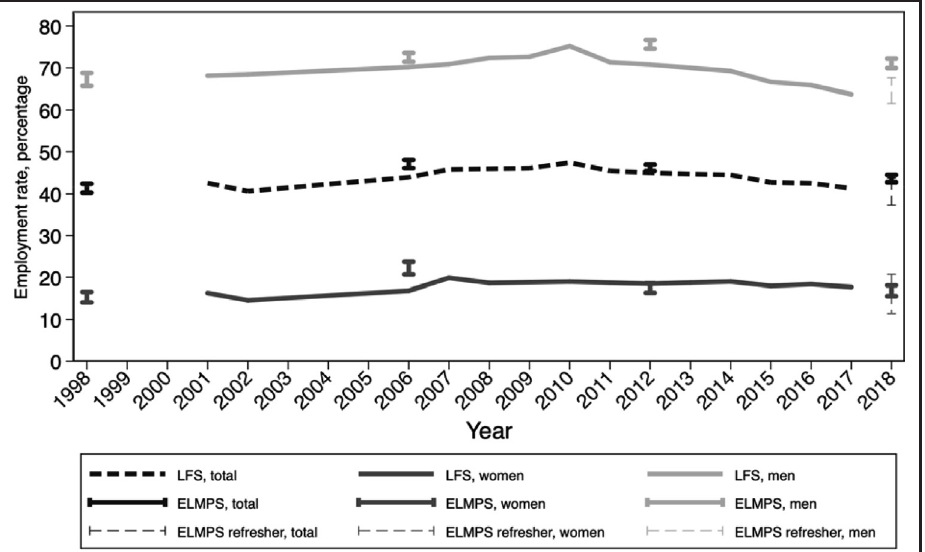
Employment rates (percentage) by sex and data source, ages 15–64, 1998–2018.